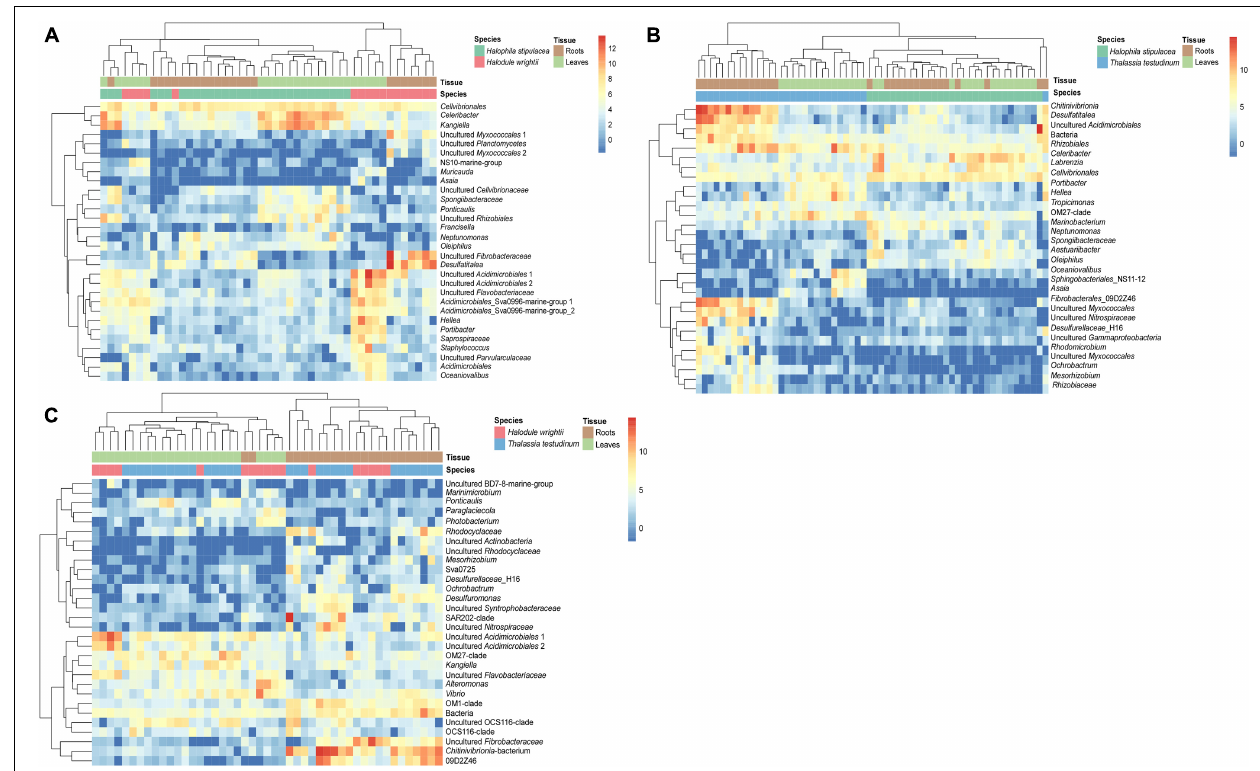
FIGURE 7 | Heatmaps of the seagrass species-associated bacterial community differential analysis. Displayed are the H. stipulacea vs. T. testudinum (A) , H. stipulacea vs. H. wrightii (B) , and H. wrightii vs. T. testudinum (C) variance stabilized transformed bacterial counts of the 30 most different abundant genera (lowest p -values, p < 0.05). Samples were ordered and clustered based on their Euclidean distance. Taxonomic names are displayed up to order